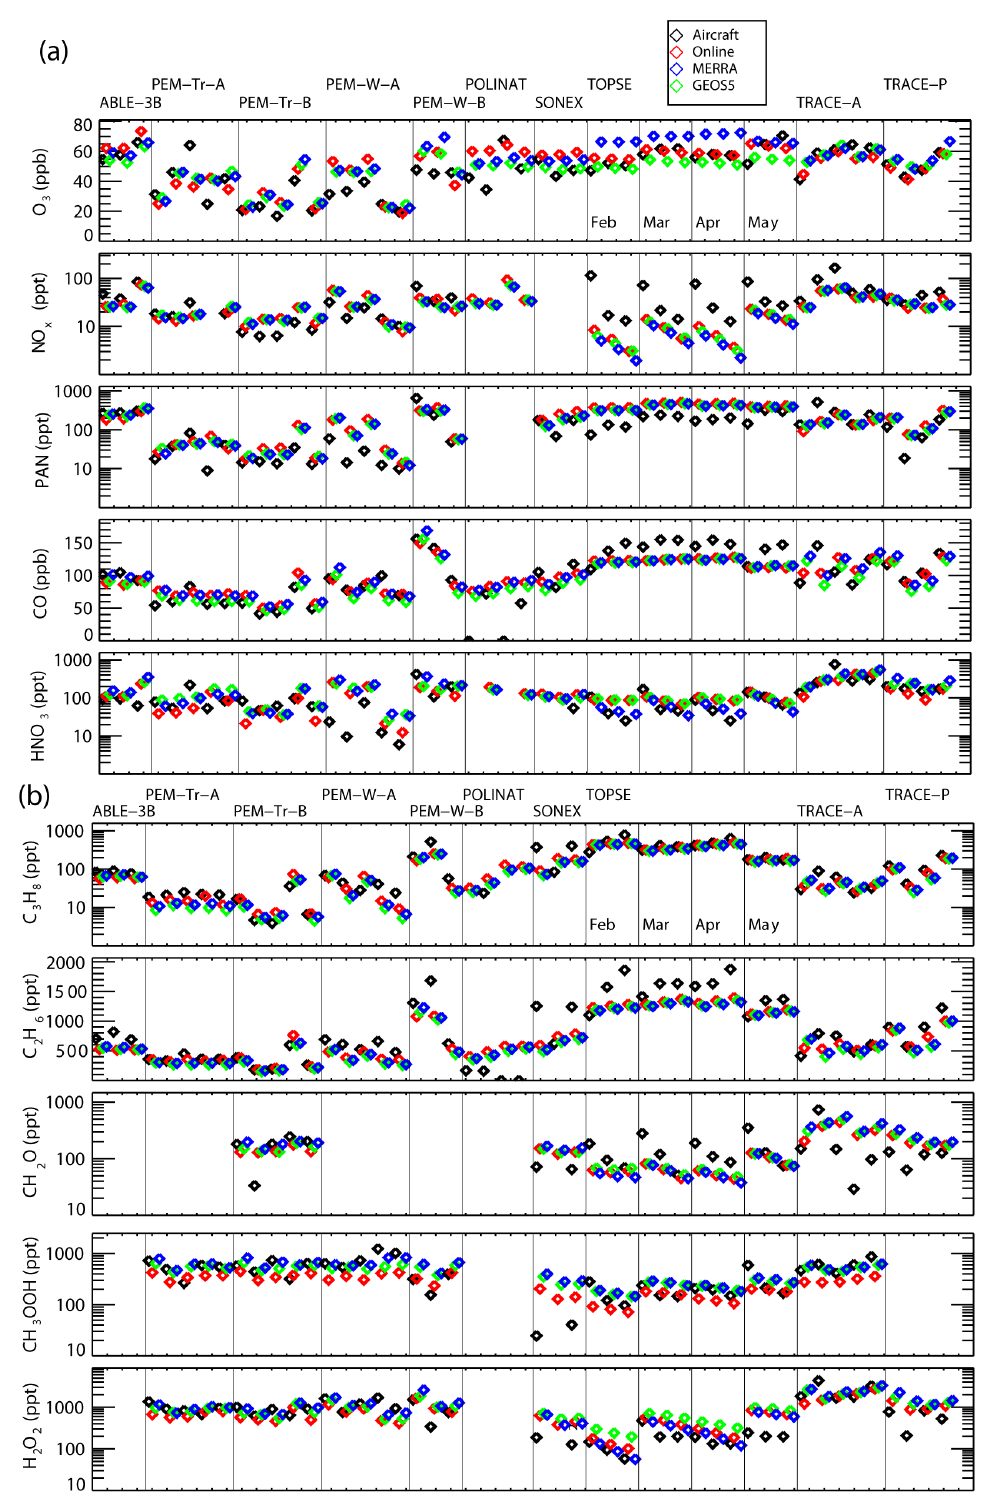
Fig. 9. (a) Comparison of regional aircraft profiles (from Emmons et al., 2000) averaged over 2–6km to the online, GEOS5 and MERRA model simulations. Each symbol represents an aircraft campaign region in the climatology. (b) Same as (a) but for additional species.